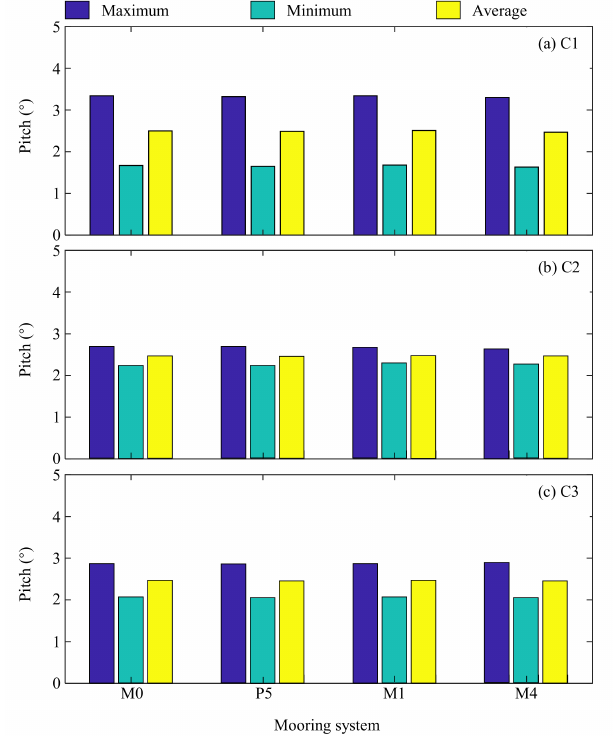
Figure 19. Maximum, minimum, and average values of wind turbine pitch movement time series with M0, P5, M1, and M4 when under: ( a ) C1; ( b ) C2; ( c ) C3.